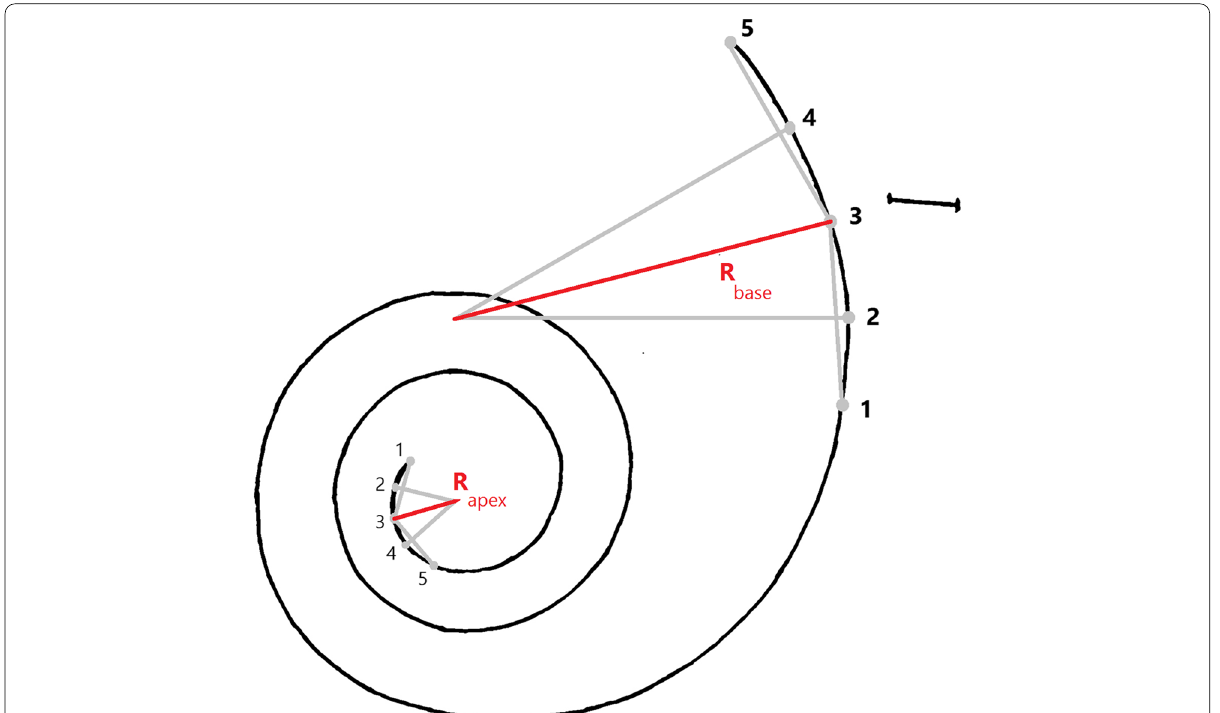
Fig. 1 Schematic of the cochlear spiral of the camel with five points used to determine radii of curvature. Spiral Radii were calculated as follows: Five equally spaced points 1–5 were chosen on each of the first and last quarter turns of the estimated basilar membrane paths. The first point was chosen just apical to the cochlear hook. Two chords were constructed between points 1 and 3 and 3 and 5. Perpendiculars to the chords were constructed through points 2 and 4. The intersection of the two perpendiculars determined an area center of curvature from which the radius was decided